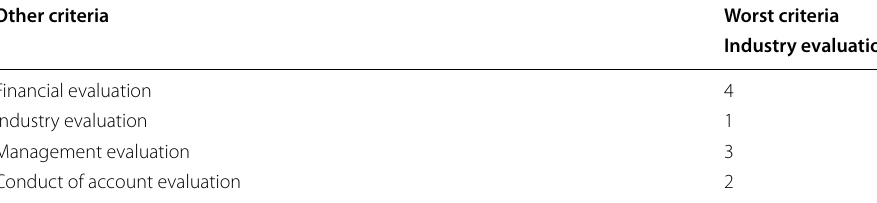
Table 3 Others-to-worst vector Other